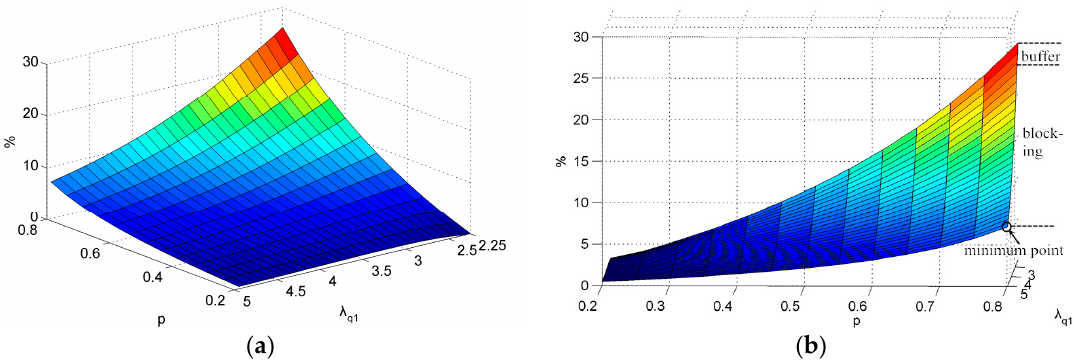
Figure 10. Improvement of the system congestion coefficient. ( a ) Three-dimensional perspective; ( b ) Side view.